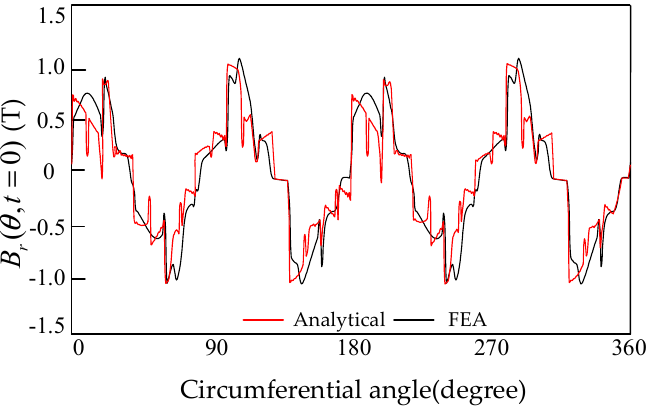
Figure 8. Comparison between analytical results and FEA of rated load air-gap flux density.